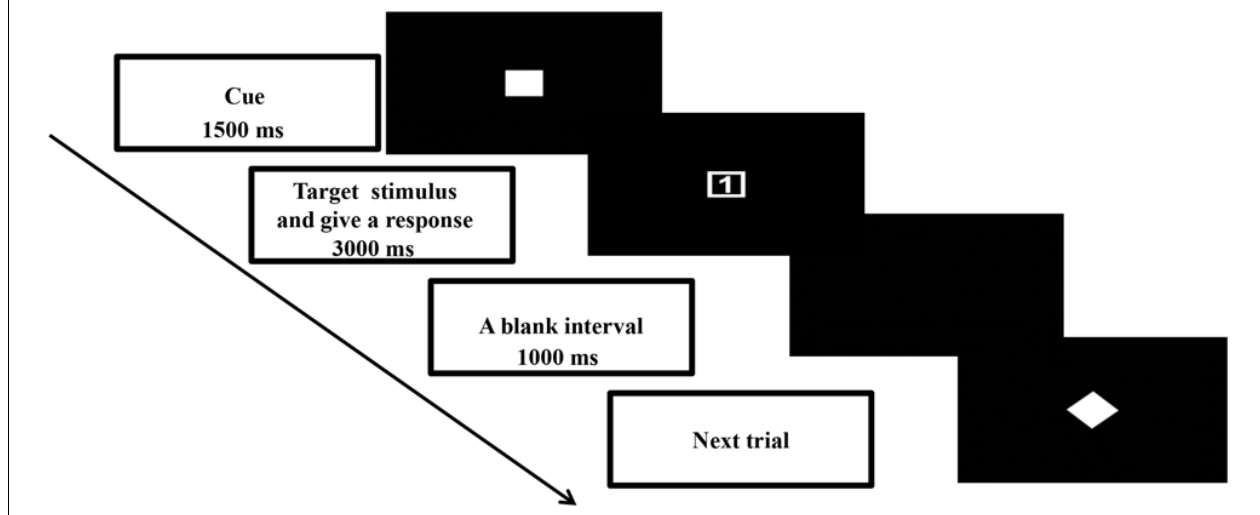
FIGURE 1 | Schematic illustration of one typical trial in the cued task-switching paradigm.